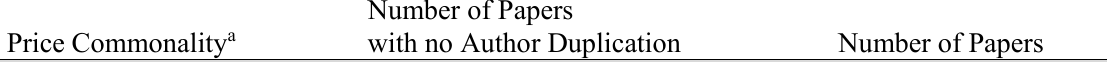
Counts of input price commonality papers using input prices Number of Papers Price Commonality a with no Author Duplication Number of Papers All Common 15 33 Mixed 20 28 All Not Common 14